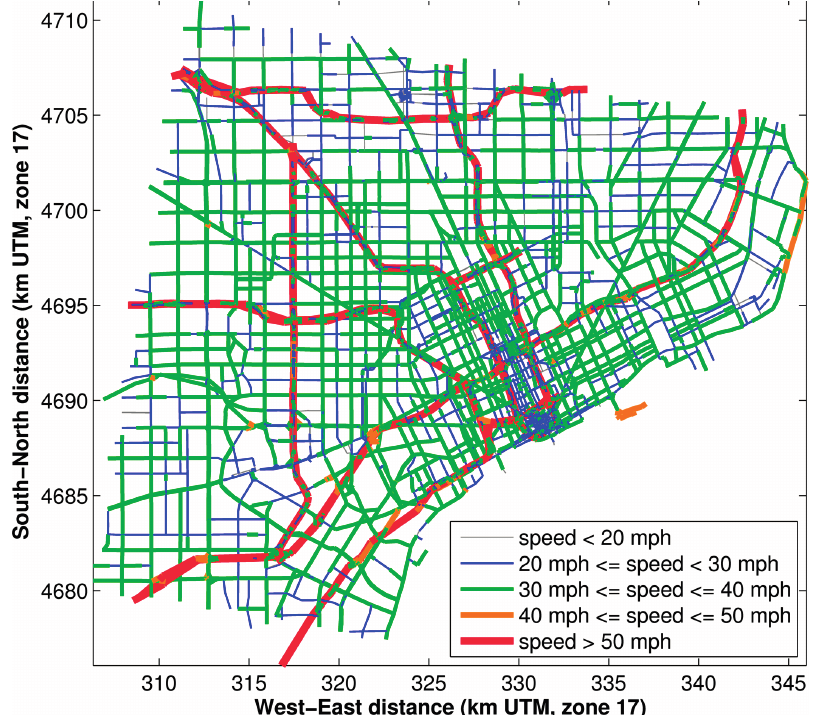
Figure 2. The average speed on each road link in the Detroit